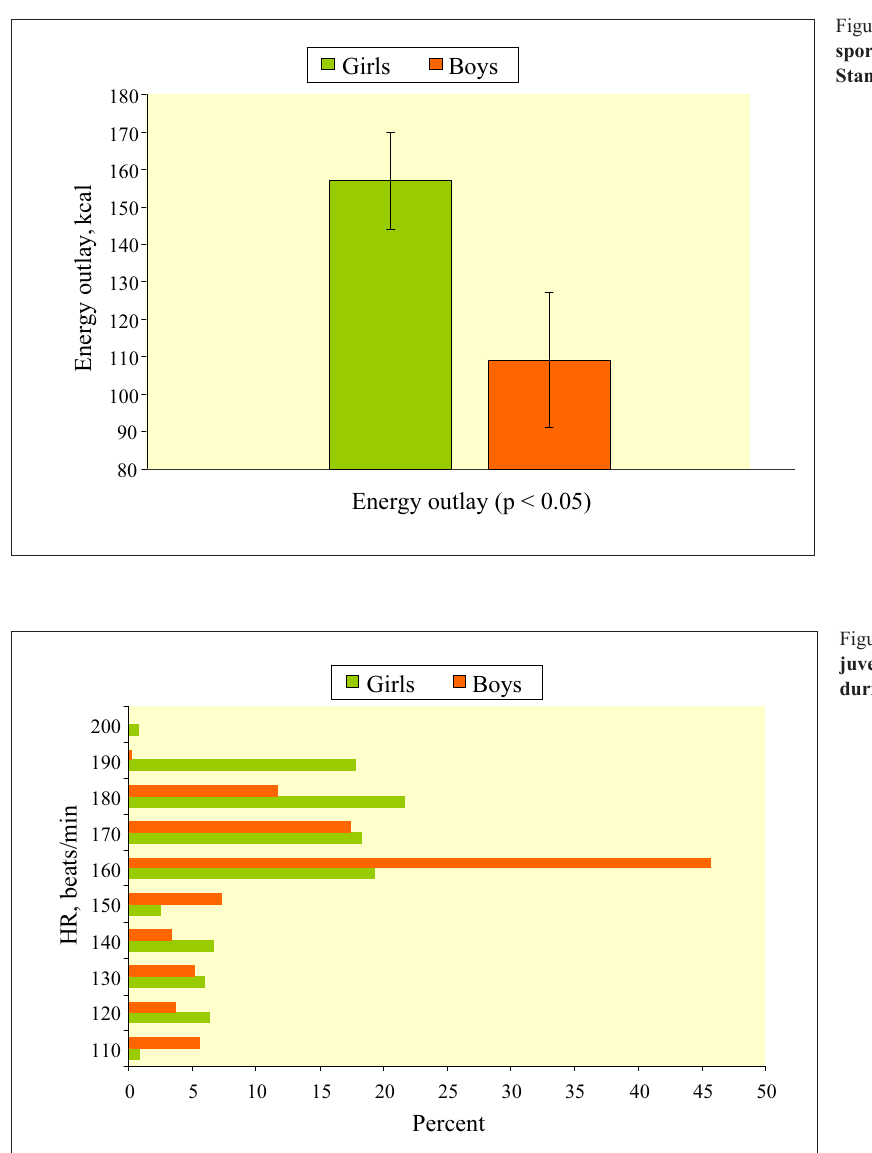
Figure 3 Percentage distribution of juvenile sports dancers’ heart rate during 10-min